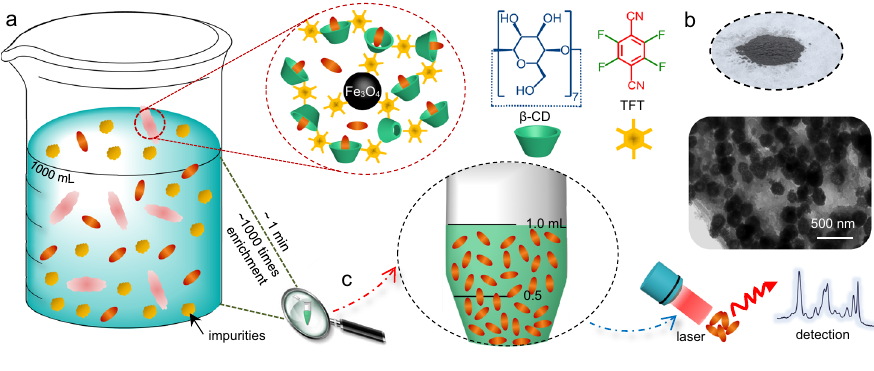
Fig. 1 Schematic of the current enrichment and detection based on the porous β -CD polymer. a Adsorption and c desorption processes using magnetic NPs immobilized porous β -CD polymer (MN-PCDP) with ~1000 times enrichment. b Optical photograph and TEM imagine of